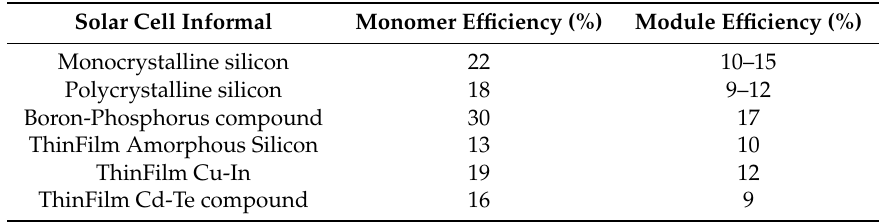
Table 1. Comparison of solar cell efficiency.